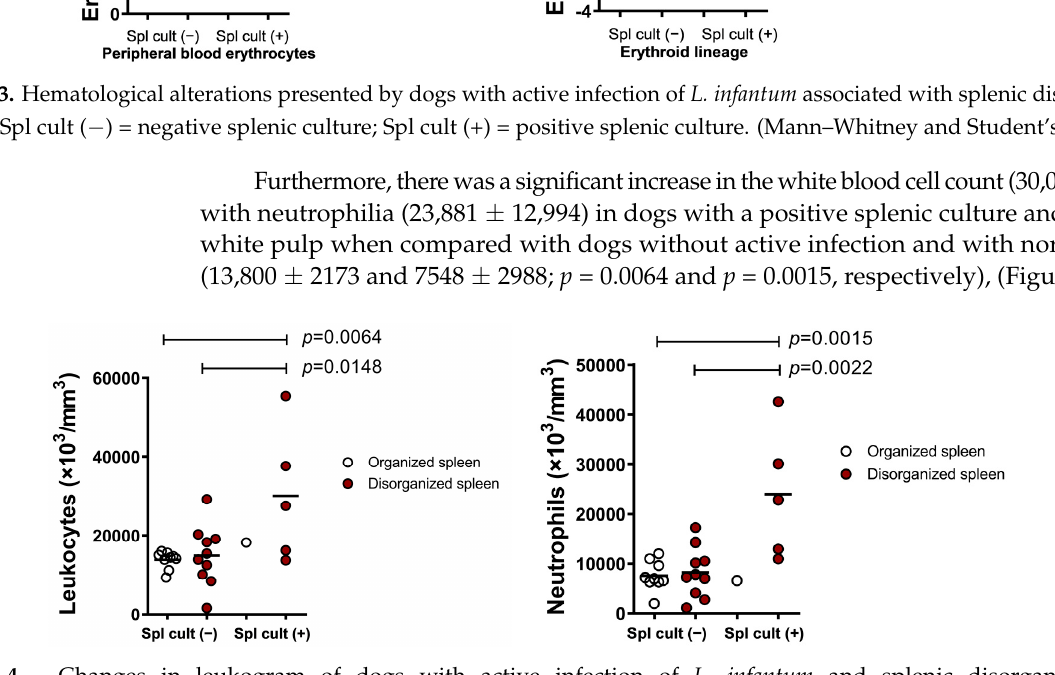
Figure 4. Changes in leukogram of dogs with active infection of L. infantum and splenic disorganization. Spl cult ( − ) = negative splenic culture and Spl cult (+) = positive splenic culture. (Student’s t - test.)